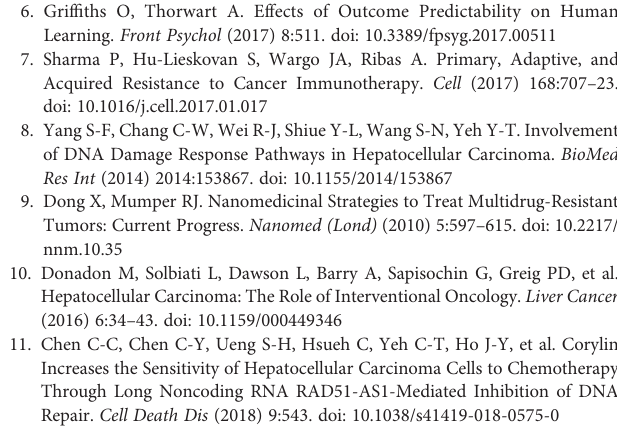
Supplementary Figure 1 | Biological function pathways, such as DNA repair, immune-related, drug resistance and immune exhaustion pathways, identi fi ed as enriched between DDR1 and DDR2 tumors in the Mongolian-LIHC cohort. GSEA of hallmark gene sets downloaded from MSigDB. All transcripts were ranked by the log2 (fold change) value between DDR1 and DDR2 tumors. Each run was performed with 1,000 permutations. Pathways with signi fi cant enrichment between DDR1 and DDR2 tumors are shown. Supplementary Figure 2 | Heatmap of core genes in signi fi cantly enriched pathways between DDR1 and DDR2 tumors in the TCGA-LIHC cohort. Supplementary Figure 3 | Heatmap of core genes in signi fi cantly enriched pathways between DDR1 and DDR2 tumors in the Mongolian-LIHC cohort. Supplementary Figure 4 | Heatmapofcoregenesinsigni fi cantlyenrichedpathways between high DDR score and low DDR score tumors in the TCGA-LIHC cohort. Supplementary Figure 5 | Heatmap of core genes in signi fi cantly enriched pathways between high DDR score and low DDR score tumors in the Mongolian- LIHC cohort. Supplementary Figure 6 | Heatmap of core genes in signi fi cantly differentially enriched pathways between high DDR score and low DDR score tumors in the ICI- treated